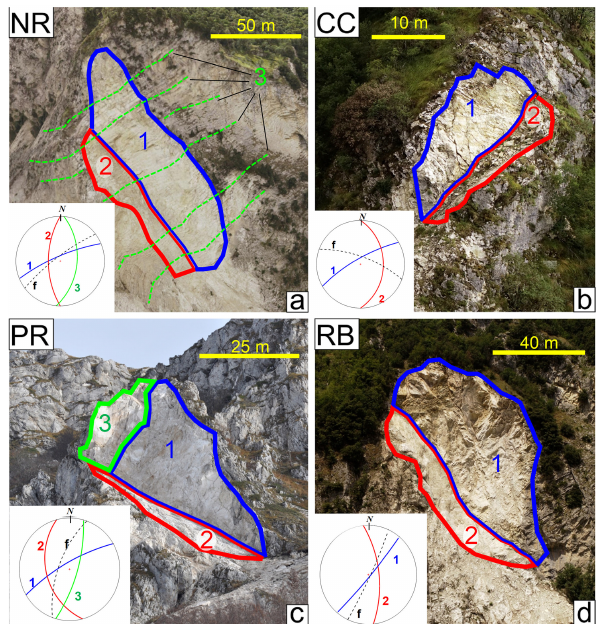
Figure 2. Frontal view of the scars of the studied rockslides with approximated limits of the mean delimiting planes: (a) Nera (NR), (b) Costa Cattiva (CC), (c) Piè la Rocca (PR) and (d) Rubbiano (RB). In the inner boxes: stereographic projections (lower hemi- sphere) of the discontinuity planes delimiting the failed masses (1, 2, 3) and of the local slope face (f) . Details are in Forte et al. (2021).